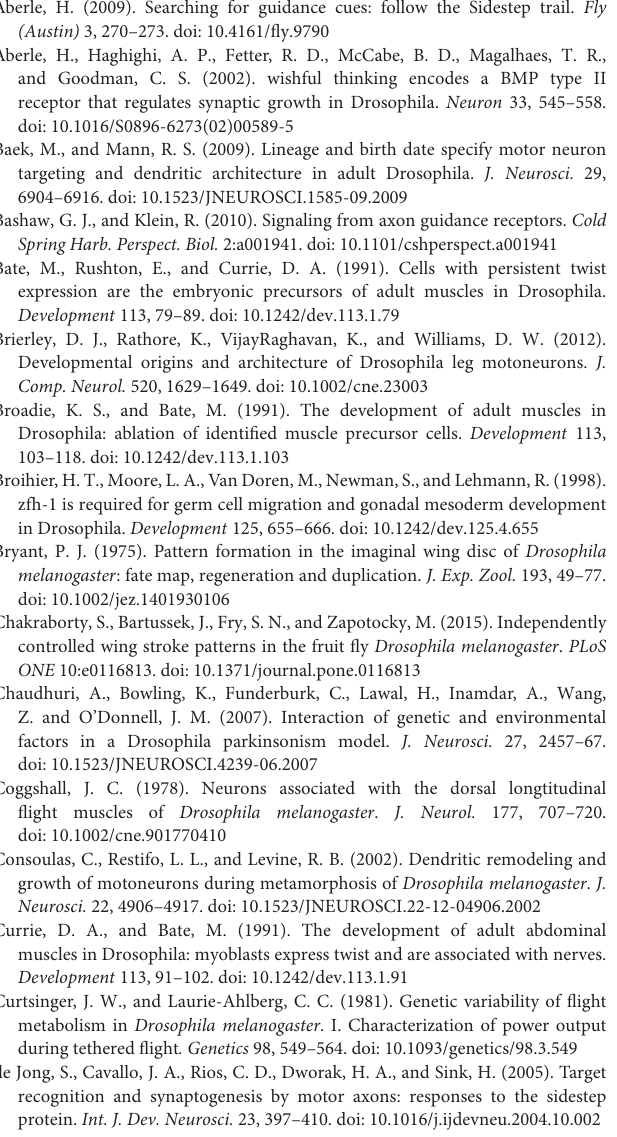
Supplementary Movie 2 | Side-induced miswiring disrupts wing-haltere coordination. While wings and halteres move in strict antiphase and maximal amplitude in ShGFP control flies, a subset of side mutant flies show reduced wing amplitudes and only minimal haltere movements. Halteres in flies overexpressing Side in muscles occasionally do not move at all despite pronounced wing amplitudes. Flight was recorded in tethered flies using a high-speed video camera set at 5,000 fps. initiate free flight, when the initial wing stroke reaches a ventral turning point. Take-off is severely compromised in flies lacking side or overexpressing it in muscles, as no or non-synchronic jumps tend to imbalance the flies. Note, aberrant leg postures but quite normal haltere movements during take-off. Foamed rubber or plastic substrates were used during the recordings (5,000